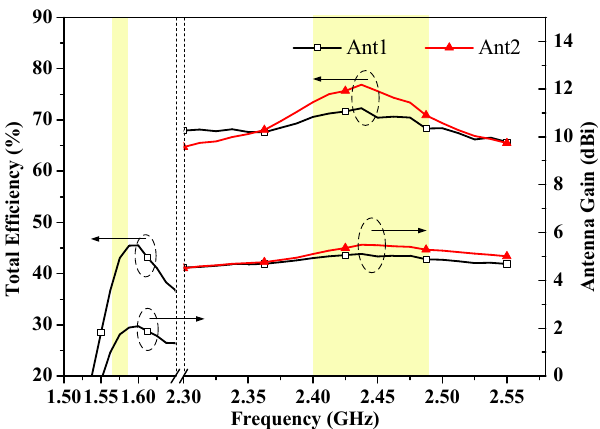
Figure 10. Measured antenna efficiency and gain for Ant1 and Ant2.